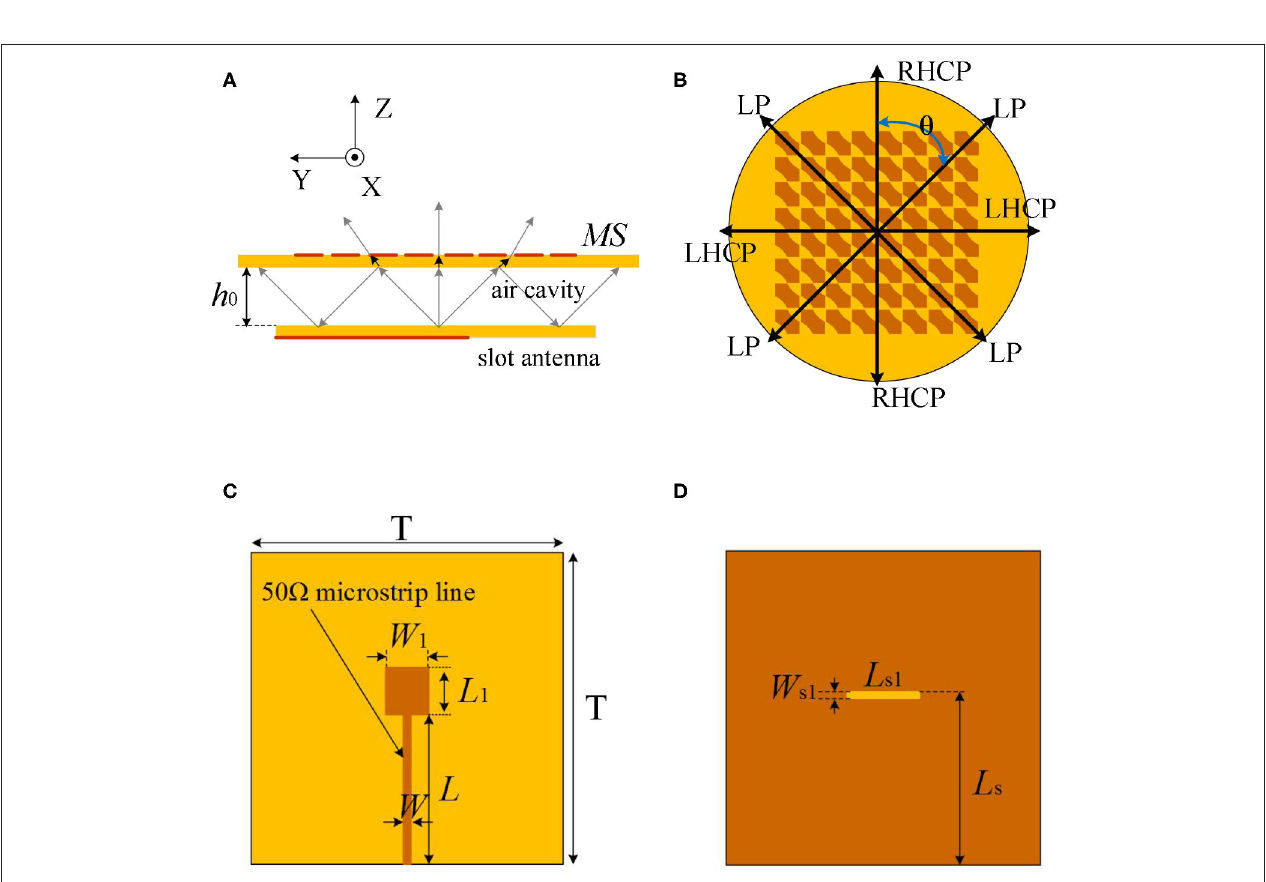
FIGURE 1 | Geometry of proposed MS. (A) top view of the MS, (B) Unit cell with corners truncated, and (C) Schematic with the size parameters of the patch.